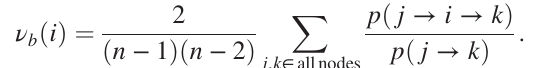
TABLE III. Factor loading ( L ) and degree, closeness, and betweenness centrality measures for factor 1 items. The values of ν c are multiplied by a constant factor of 10 3